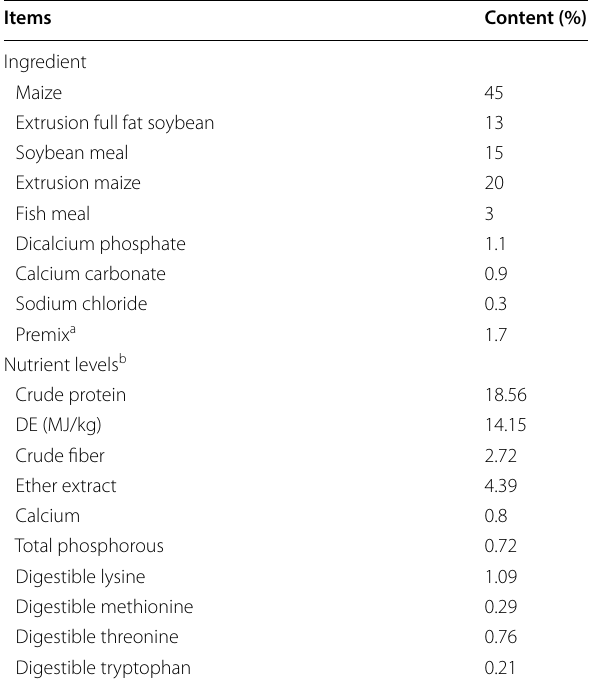
Table 1 Composition and nutrition levels of the basal diet (as-fed